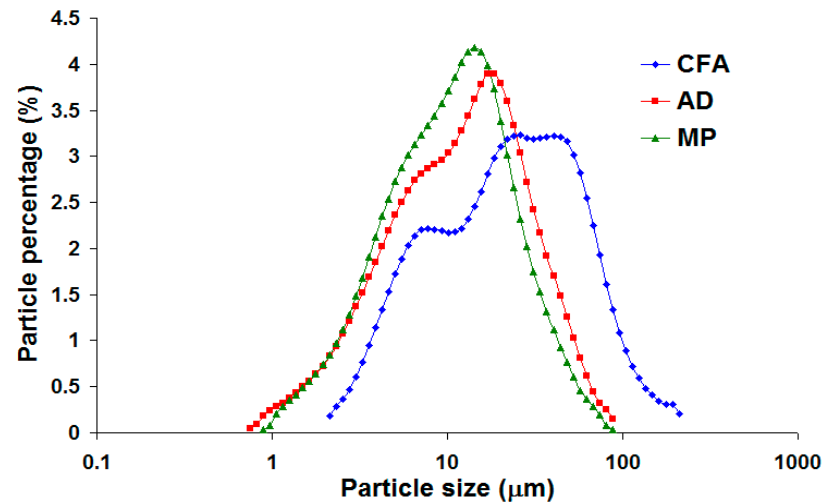
Figure 3. Particle size distributions (logarithmic scale on x-axis) of the CFA, AD and mullite precursor powder.